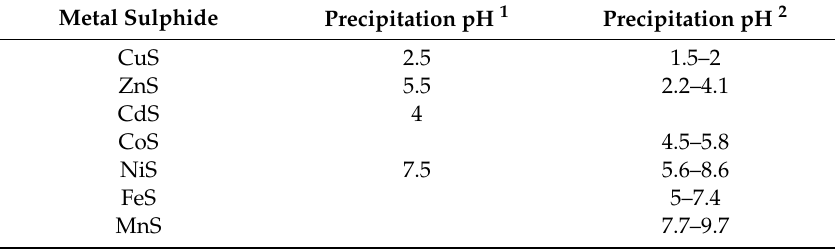
Table 2. Theoretical pH values for metal sulphide precipitation